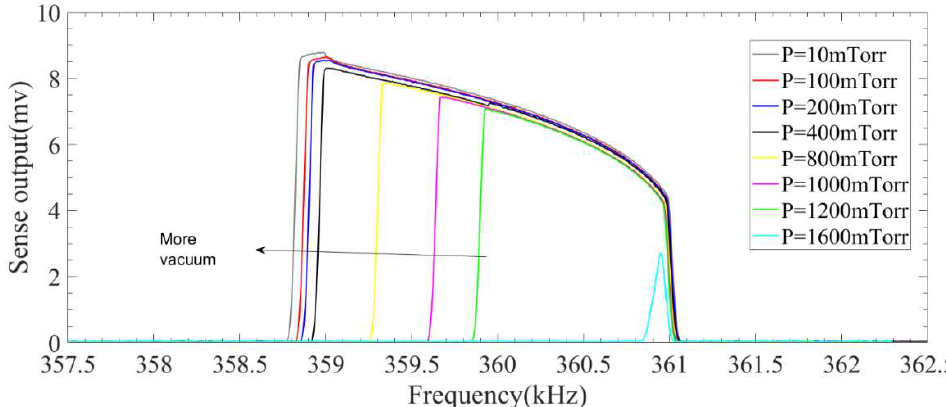
Figure 13. Effect of pressure on the performance of the system in the presence of internal resonance in a backward frequency sweep.